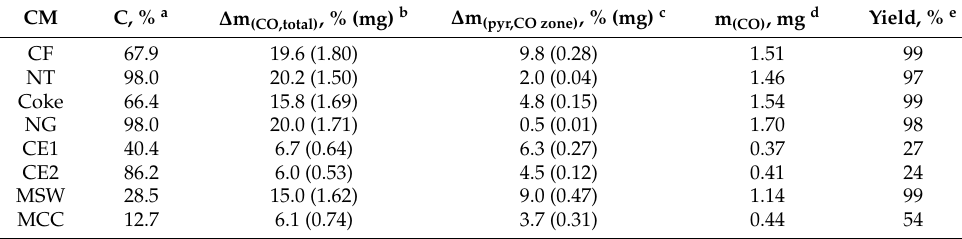
Table 1. Calcium carbide yield data in